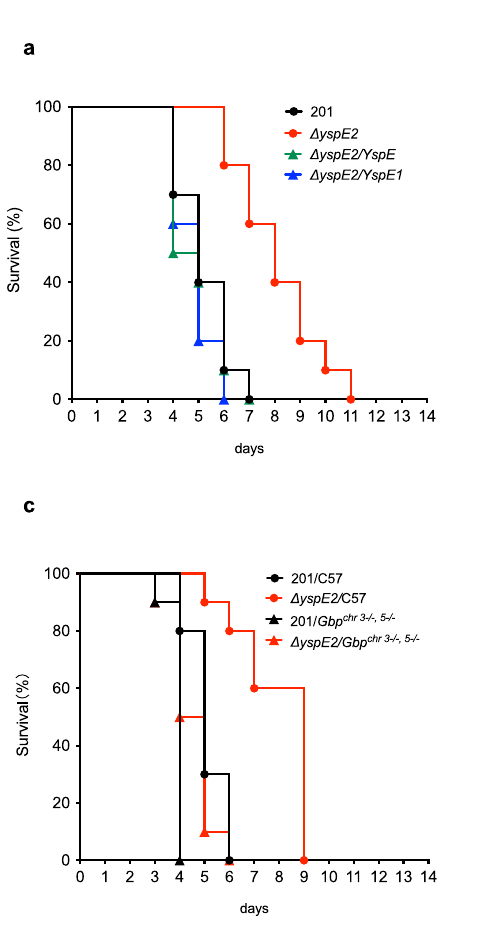
Fig. 8 | YspE1/YspE2 contribute signi fi cantly to the virulence of Y. pestis and Gbp chr3 − / − ,chr5 − / − mice were more susceptible to Y. pestis infection. a Groups of female C57BL/6J mice ( n =10 per group, 6 to 8 weeks) were s.c . challenged with Y. pestis 201 (WT), Δ yspE2 , Δ yspE2 /YspE1 or Δ yspE2 /YspE2, and survival curves were plotted. Δ yspE2 signi fi cantly attenuated in virulence in mice ( p <0.001) and no signi fi cant difference exist between survival curves of 201 and YspE1- or YspE2- complemented yspE2 mutant. Log-rank test was performed using GraphPad Prism 8.0 to analyze the signi fi cance of difference in survival curves. b Bacterial loads of Δ yspE2 intissuesofmiceharvestedat4dpiweresigni fi cantlylowerthanthoseof Y. pestis 201 in s.c . challenged C57BL/6J mice. One-way ANOVA was performed using GraphPad Prism 8.0 to analyze the signi fi cance of difference in bacterial loads in thedifferenttissues. c GroupsofC57BL/6Jmiceand Gbp chr3 − / − ,chr5 − / − mice( n =10per group,6to8weeks)were s.c .challengedwith Y.pestis 201or Δ yspE2 .Comparedto C57BL/6J mice, Gbp chr3 − / − ,chr5 − / − mice are much more susceptible to both strains in subcutaneous infection ( p <0.001), and the signi fi cance of difference between survival curves of the two strains in C57BL/6J mice ( p <0.001) were